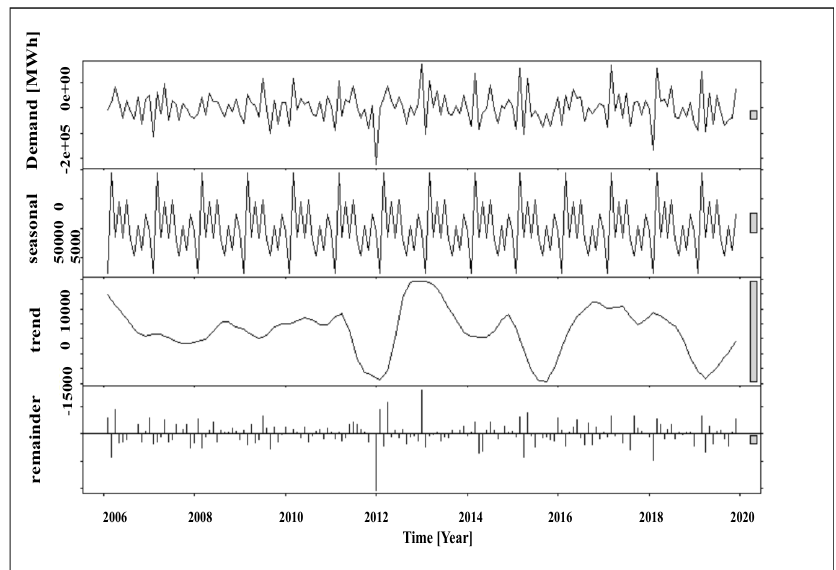
Figure 8. Monthly electricity demand time series decomposition.